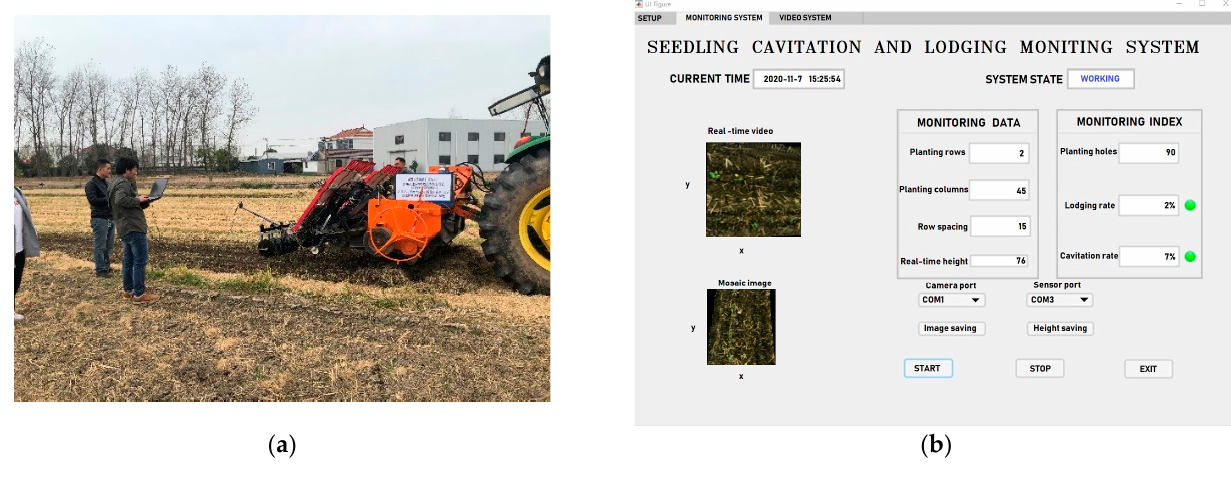
Figure 6. Field test and system monitoring interface. ( a ) Test prototype, ( b ) Cavitation and lodging monitoring platform.